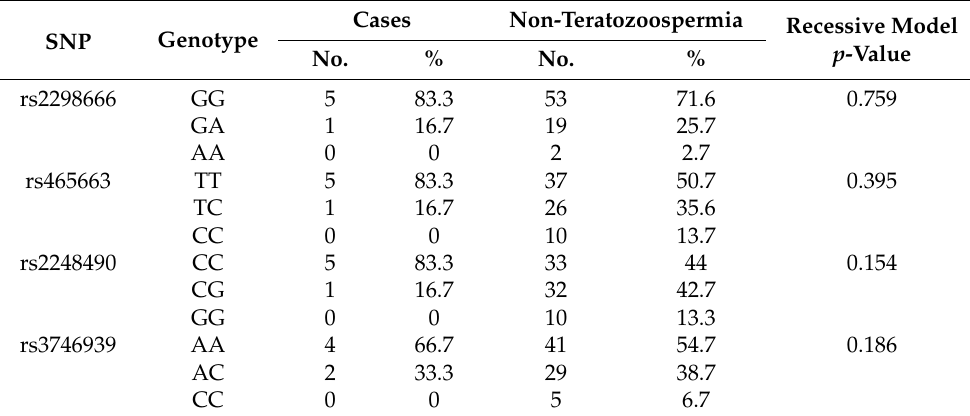
Table 4. Associations between genetic variants of the WDR4 gene and teratozoospermia.